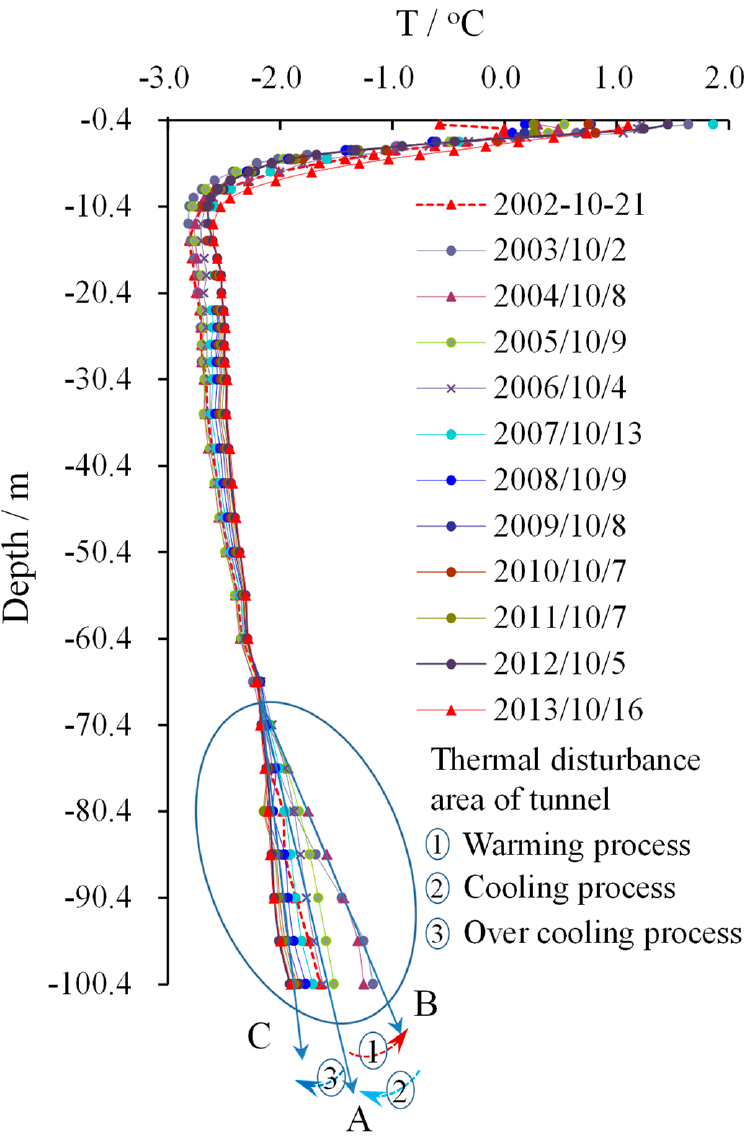
Figure 2. In-situ geothermal observation of surrounding rock of a permafrost tunnel during the construction and operation process [56].